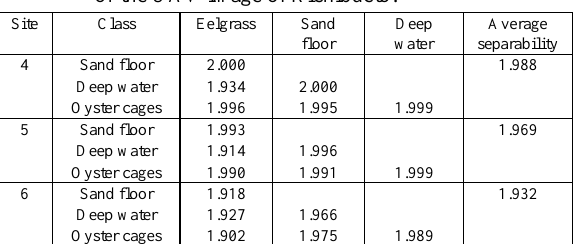
J–M distances computed with all the band reflectance of the UAV image of Richibucto.